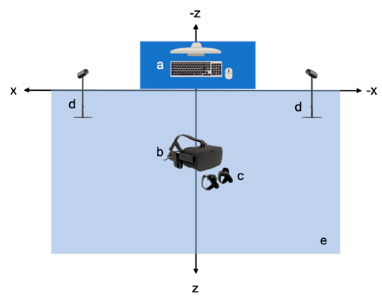
Figure 7. Setup of the VR-HC System: (a) Desktop Computer, (b) Oculus Rift VR Headset, (c) Oculus Rift Hand Controllers, (d) Oculus Rift Sensor, (e) VR-HC User Action Area.